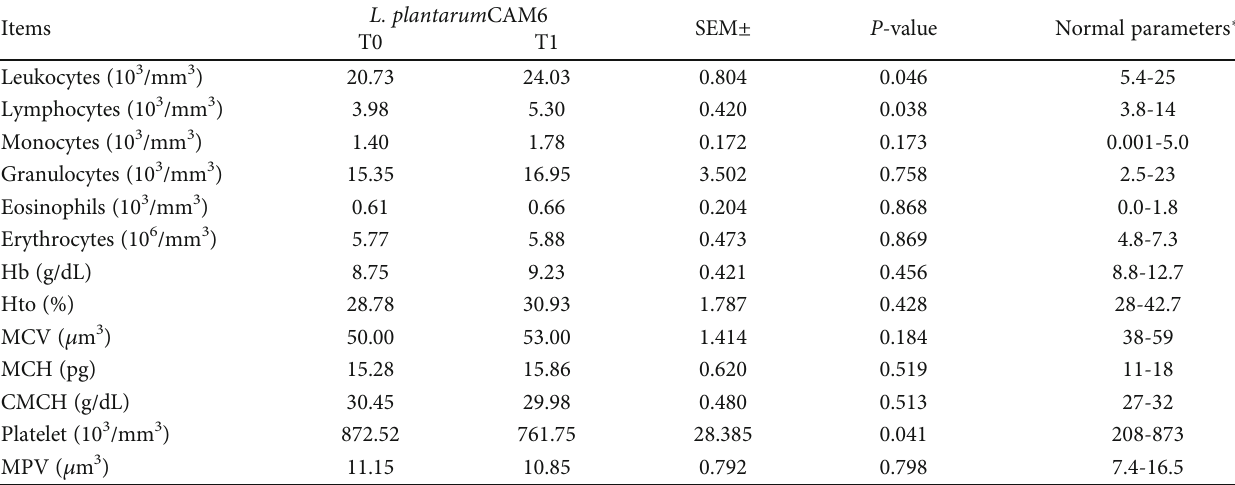
Table 4: The derived in fl uence of oral administration with Lactobacillus plantarum CAM6 in sows towards the hematological parameters of their lactating piglets (28 days of